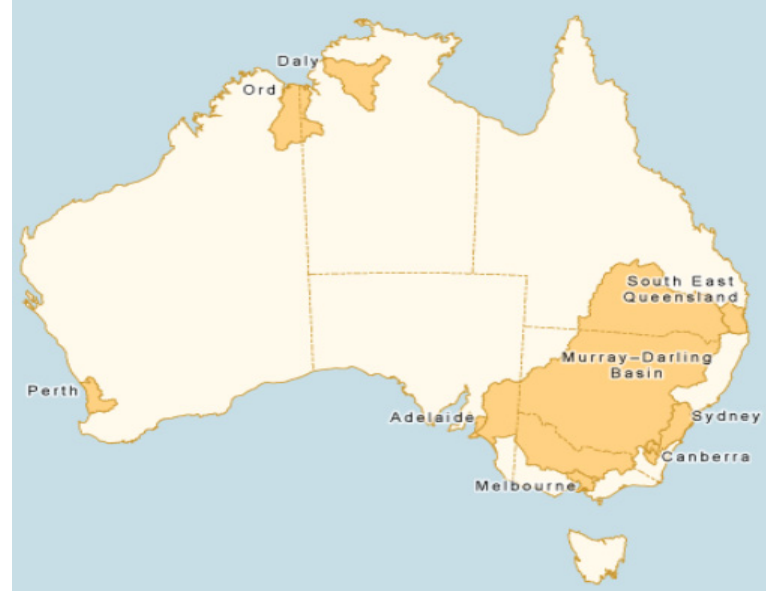
Figure 1. Coverage of National Water Account, 2013. Source: